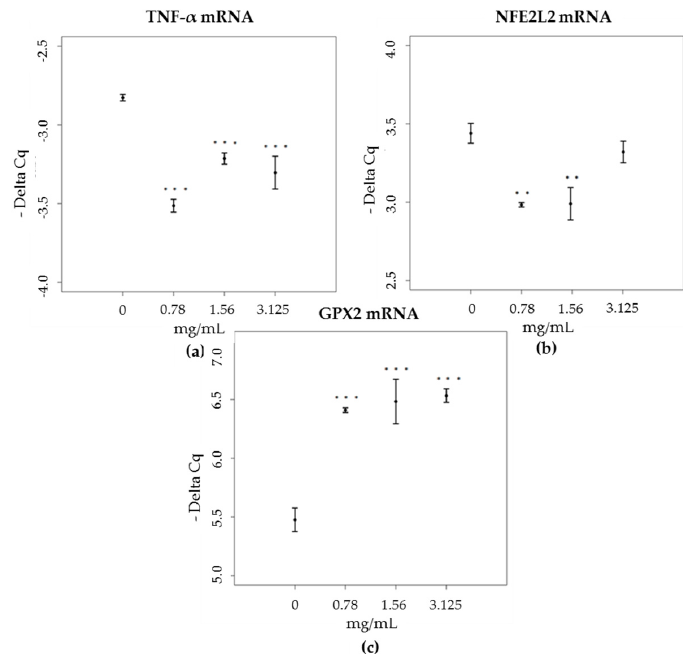
Figure 7. Expression levels ( ‐ Delta Cq) of mRNA coding for ( a ) TNF ‐α , in HaCat cells, treated with increasing concentrations of brown propolis extract (0.78–3.125 mg/mL), ( b ) NFe2L2, in HaCat cells, treated with increasing concentrations of brown propolis extract (0.78–3.125 mg/mL), ( c ) GPX2, in HaCat cells, treated with increasing concentrations of brown propolis extract (0.78–3.125 mg/mL).